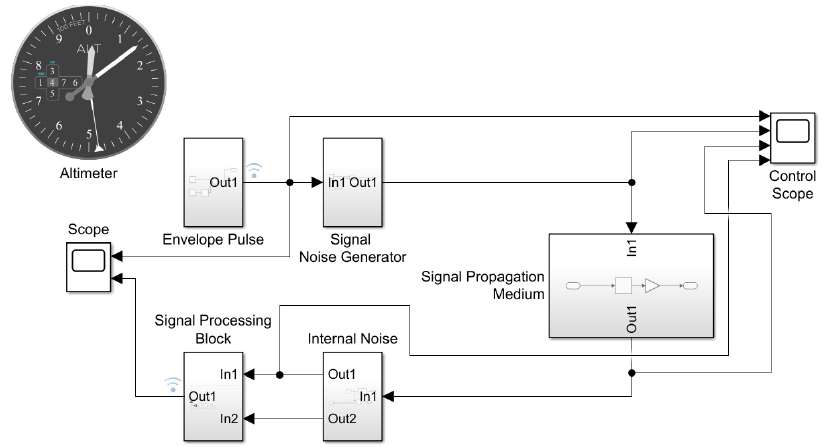
Figure 2. A simulation model of a wideband altimeter containing a transceiver part and realizing signal distortion during its propagation in the environment and reflection from the underlying surface.